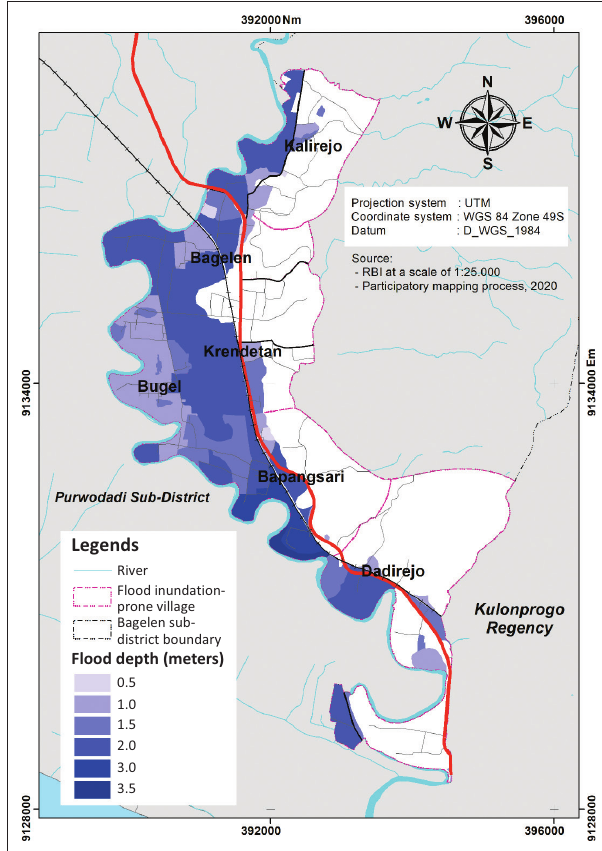
FIGURE 5: Flood depth